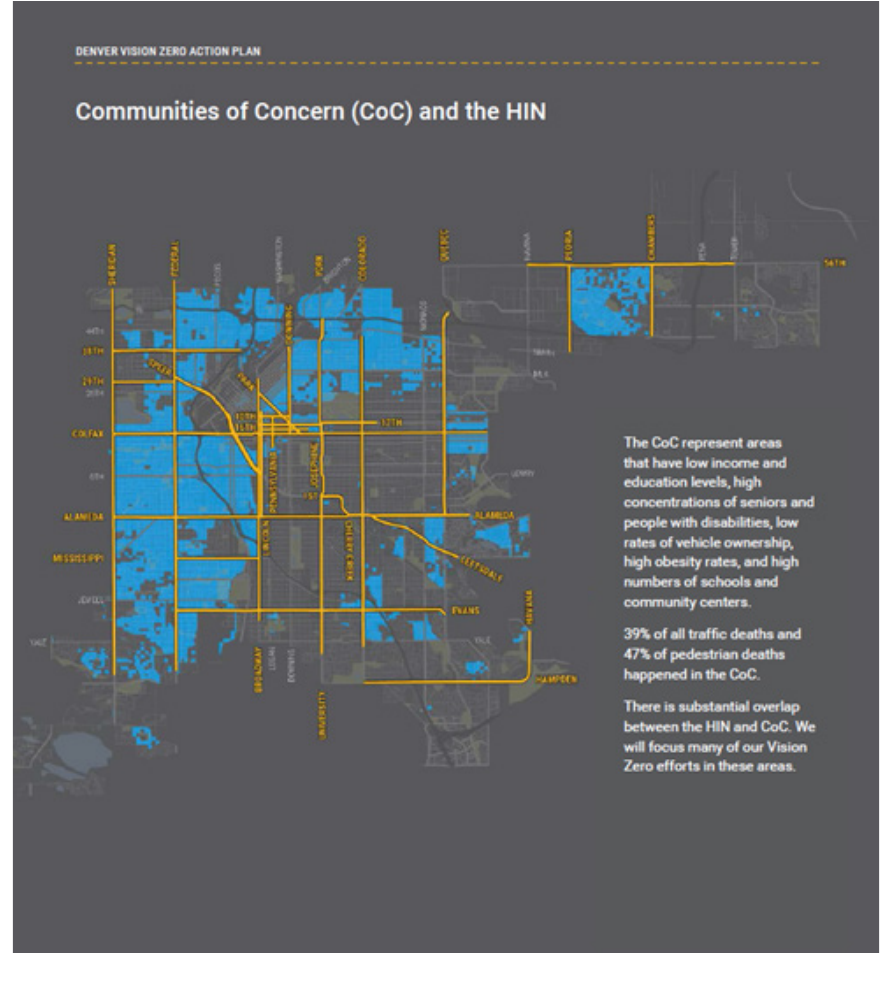
Figure 5: Denver Communities of Concern and the High-Injury